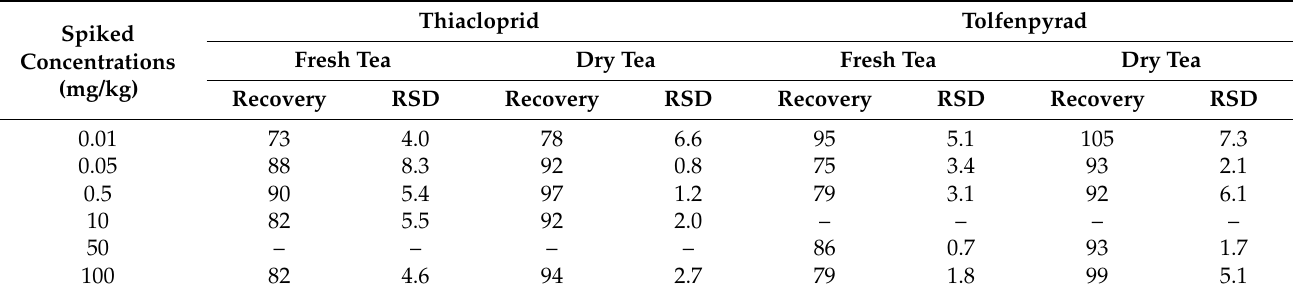
Table 2. The mean recovery (%) and RSD (%) for thiacloprid and tolfenpyrad from samples of dry and fresh tea at five spiked concentrations ( n =